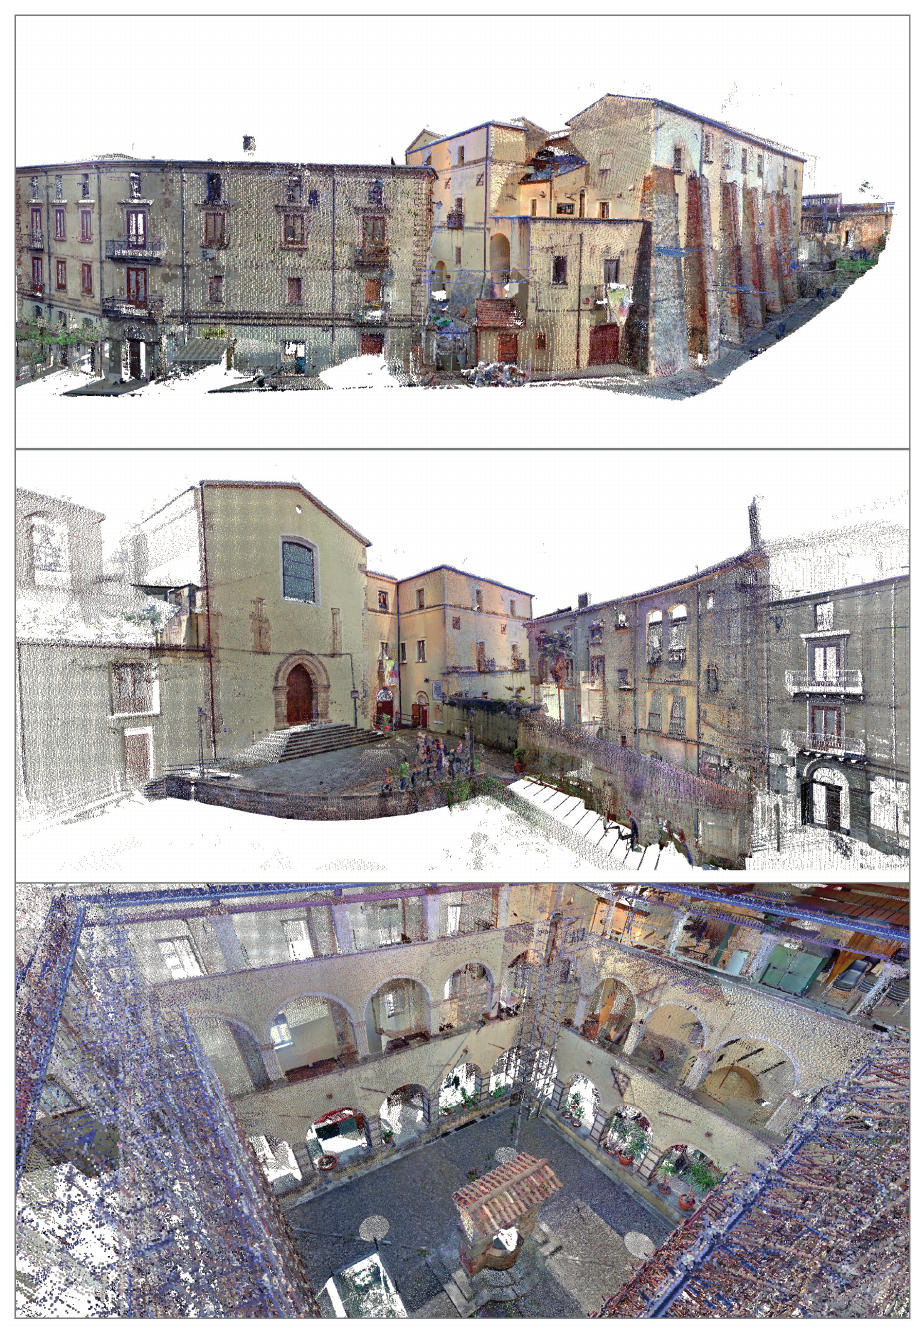
Figure 3. Views of the tridimensional model of the St. Augustine monumental compound obtained by alignment of the